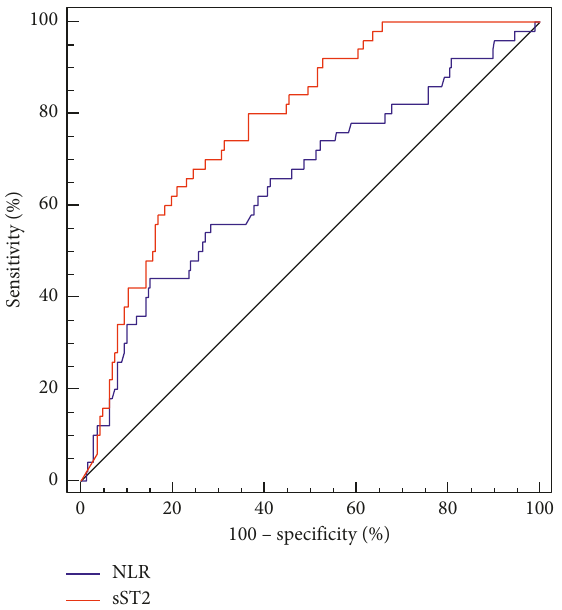
Figure 2: ROC curve showing the distinguishing ability of sST2 and NLR level for